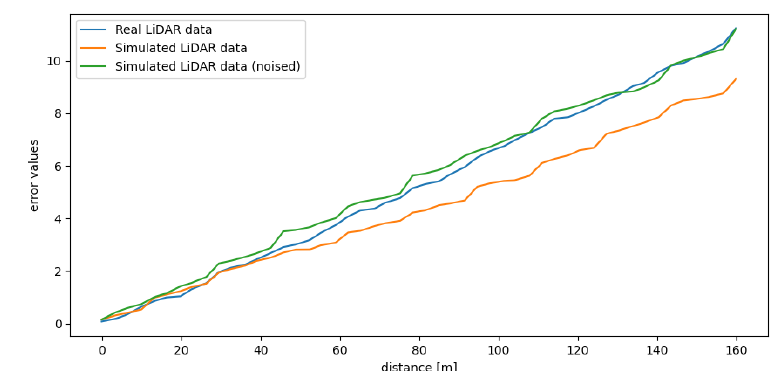
Figure 13. SLAM accuracy metric for real data and simulated data generated for the second track (obtained on this track for a vehicle travelling back and forth along this route).